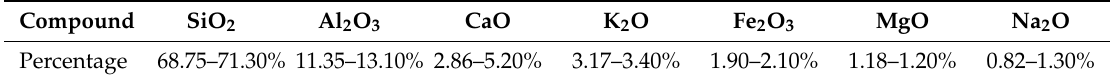
Table 1. The chemical composition of micronized zeolite clinoptilolite (MZC).